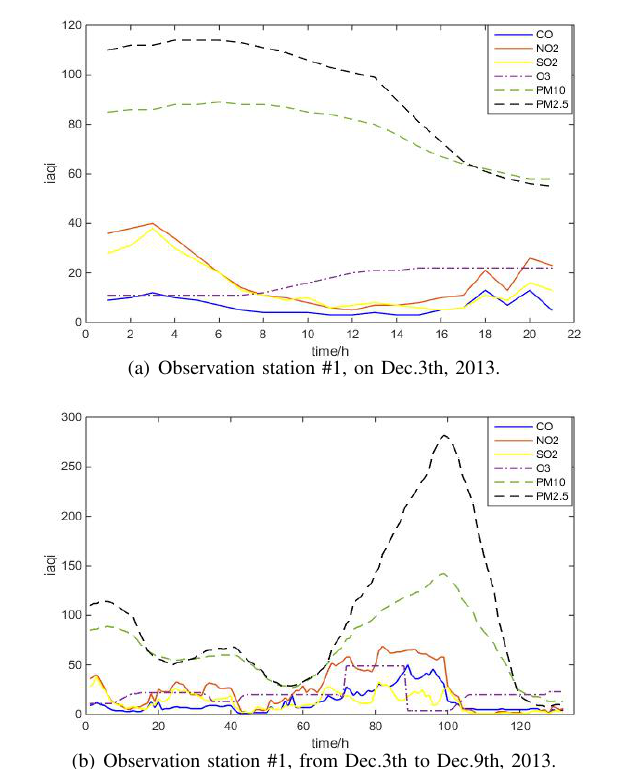
Fig. 2. IAQI waves per day and per week of the observation station #1.